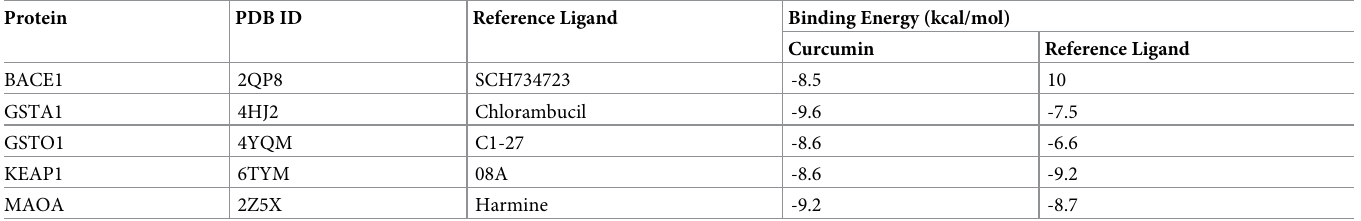
Table 2. Estimated binding energies from Vina molecular docking.